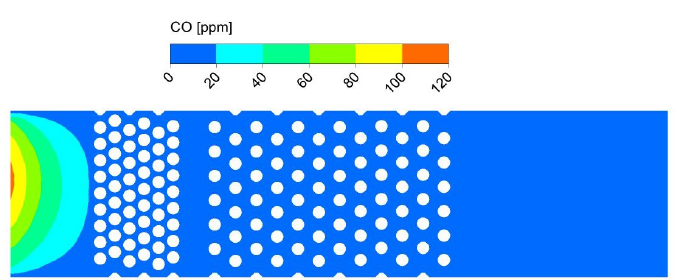
Figure 19. Flame visualization in the radiant section.